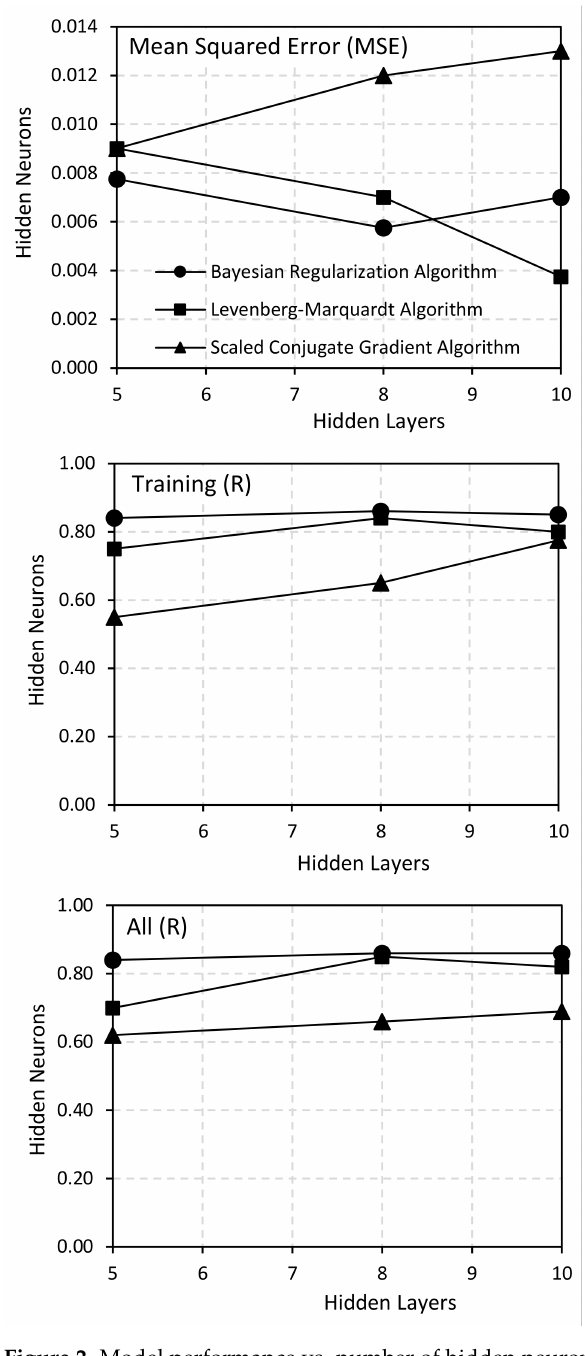
Figure 2. Model performance vs. number of hidden neurons for each